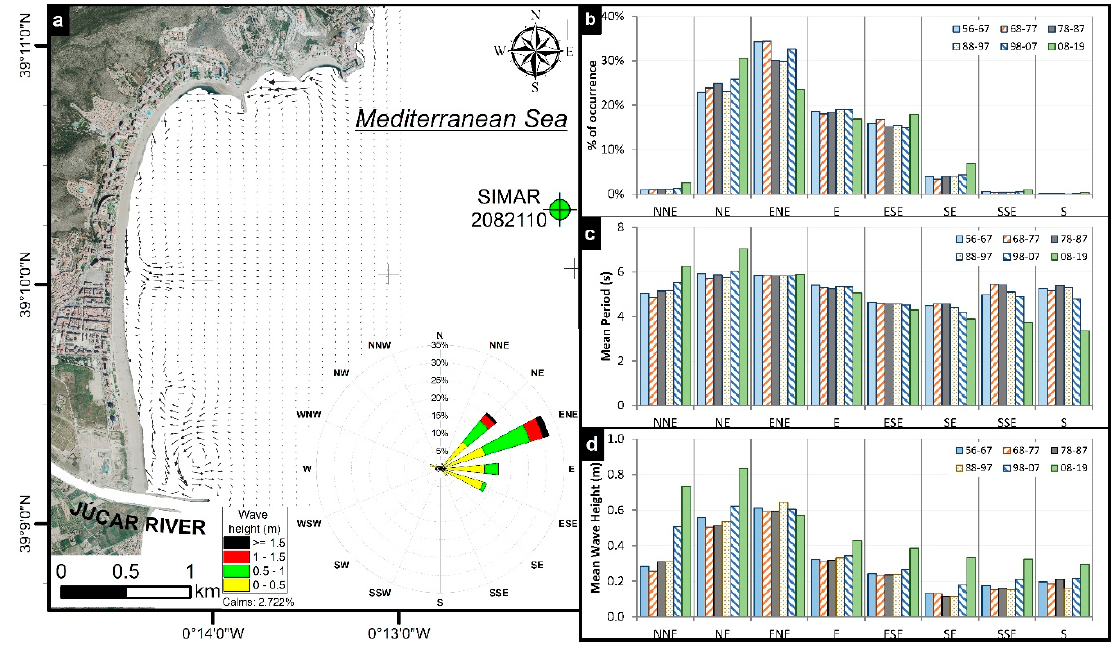
Figure 8. ( a ) Position of the SIMAR Node and currents generated by the mean wave flow. ( b ) Evolution of the percentage of occurrence of each of the study directions. ( c ) Evolution of the mean period of each of the study directions. ( d ) Evolution of the mean wave height of each of the study directions.